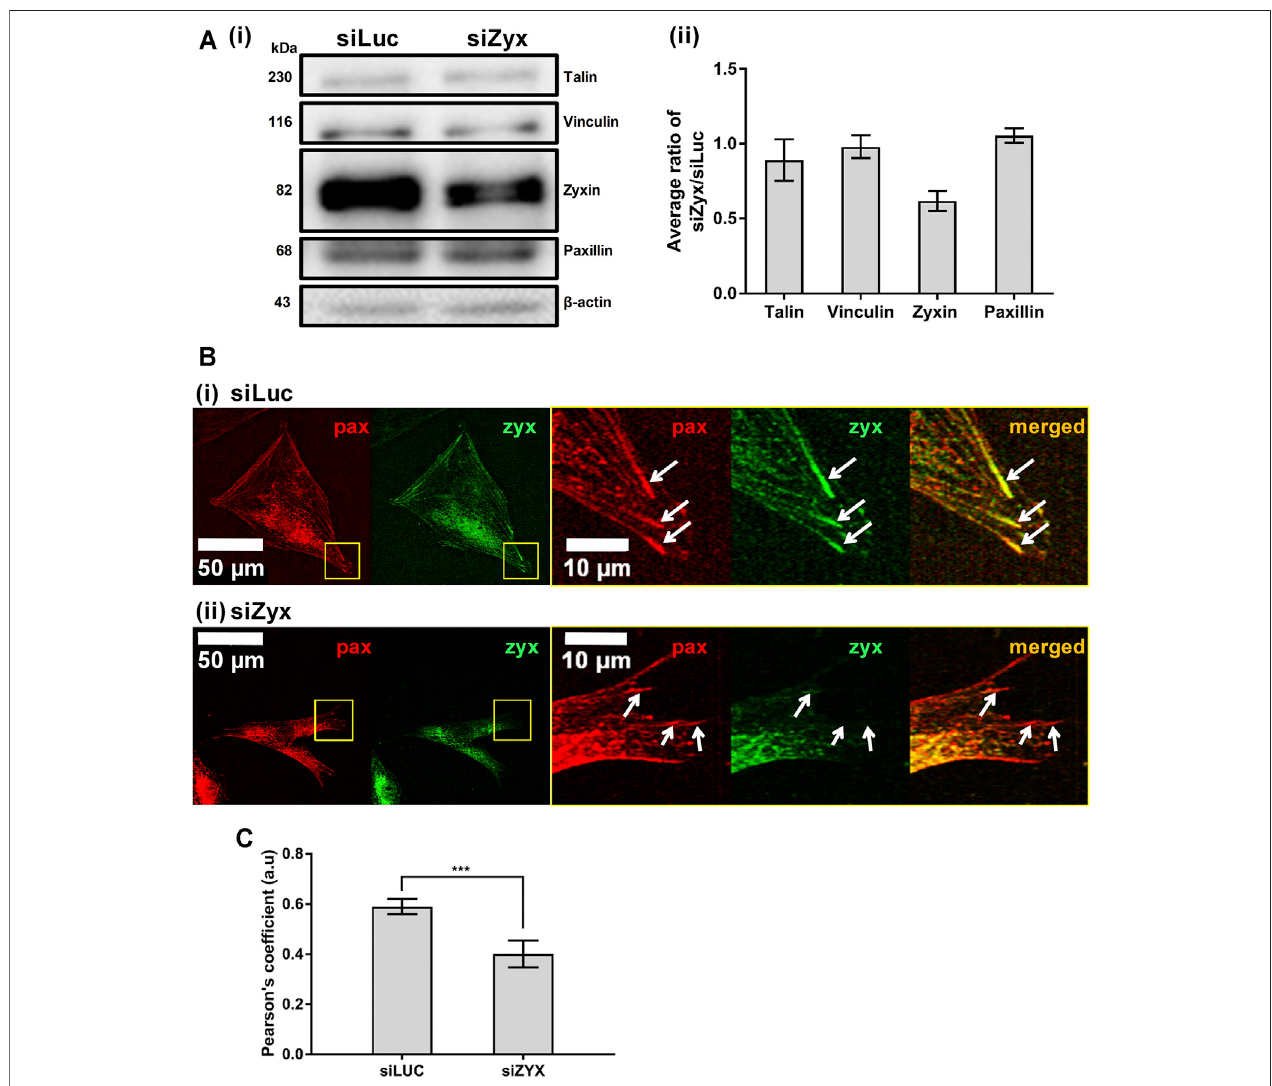
FIGURE 1 | Knocking down zyxin in NIH3T3 cells does not affect levels of other FA proteins (A) 1) Western blot and 2) its quanti fi cation showing levels of zyxin in NIH3T3cellstransfectedwithacontrolsiRNA(siLuc)andzyxinsiRNA(siZyx). β -actinlevelsareusedasloadingcontrol(n (cid:2) 3) (B) immuno fl uorescencestainingforpaxillin (red)andzyxin(green)in1)controlsiLuc-NIH3T3and2)zyxinknockdownsiZyx-NIH3T3cellsonastiffpolyacrylamidegel(61 kPa).Rightpanelsshowthemagni fi edview of the yellow boxes and the white arrows denote the FA stained by paxillin (red) (C) Quanti fi cation of zyxin colocalization with paxillin in siLuc-NIH3T3 and siZyx- NIH3T3 cells on the stiff polyacrylamide substrate (61 kPa). Pearson ’ s coef fi cient of 1 indicates perfect colocalization, 0 indicates no colocalization (n (cid:2) 8). Error bars represent standard error of the mean. *** represents p < 0.005.